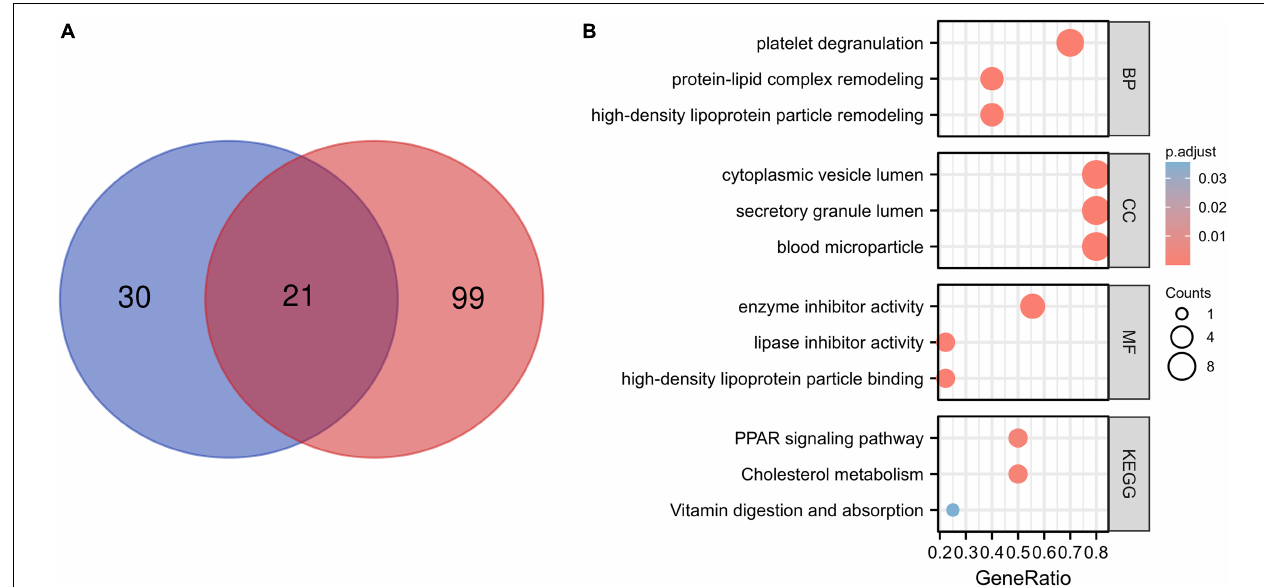
FIGURE 2 | Proteome of the patients with COVID-19 and enrichment analysis. (A) A total of 21 common proteins were identified according to the proteome of the sera and plasma from patients with COVID-19 by Venn diagram. The blue color shows the proteome of sera of patients with COVID-19, and the red color shows plasma proteome associated with COVID-19. (B) A total of 21 common proteins involved in lipid pathway by the enrichment analysis, for example, protein–lipid complex remodeling and high-density lipoprotein particle remodeling.